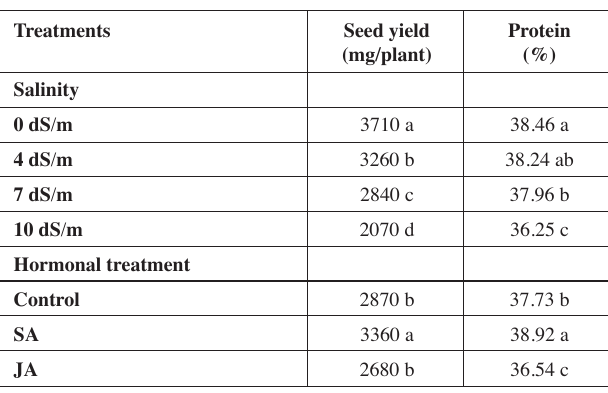
Tab. 1: Means of soybean seed yield and protein percentages under different salinity and hormonal treatments Treatments